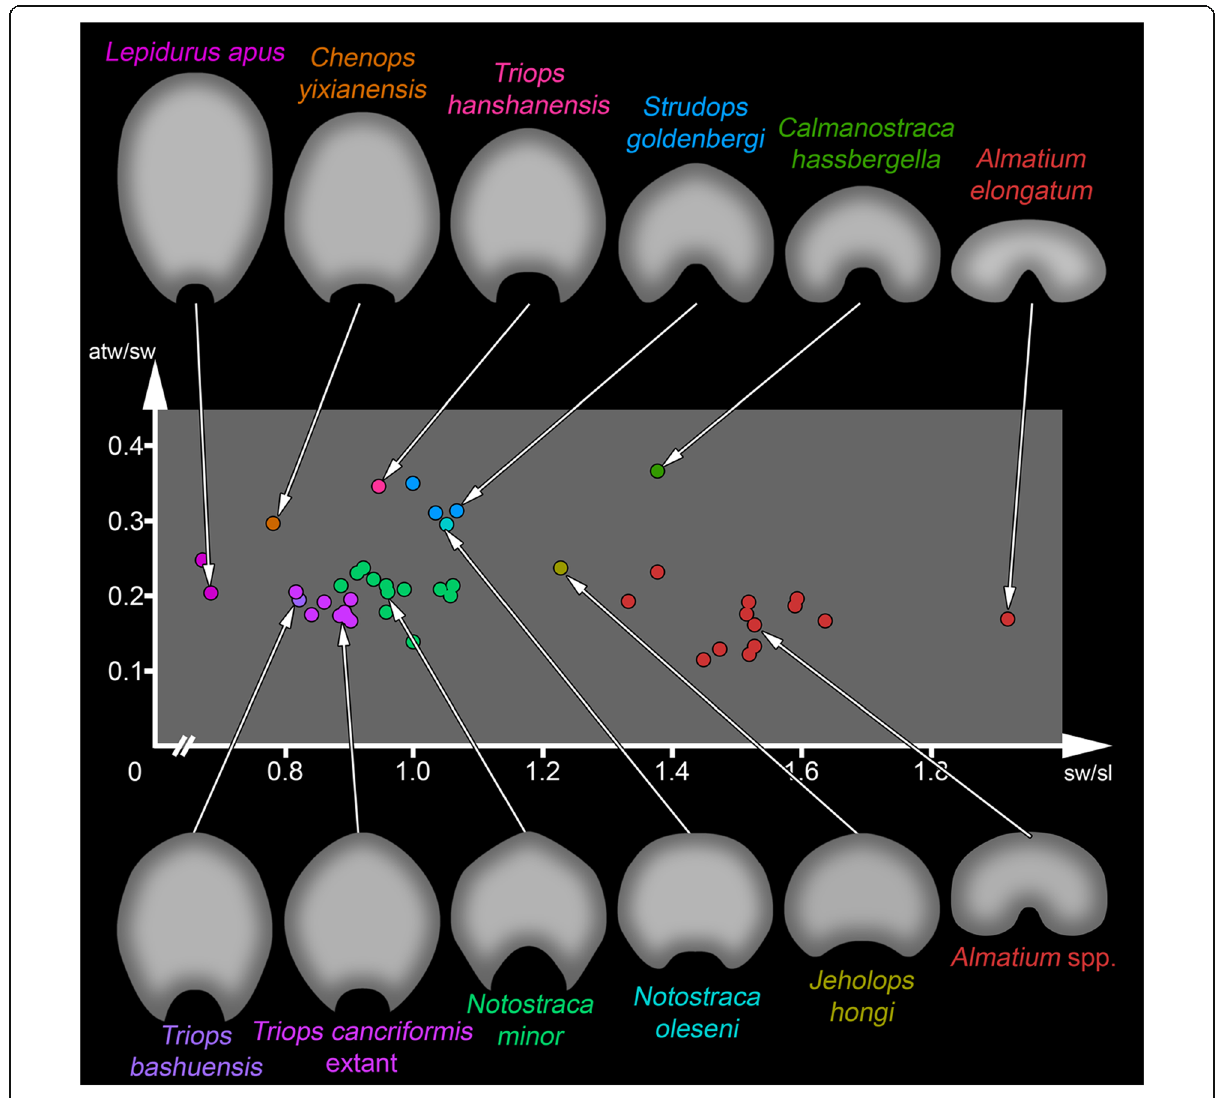
Fig. 3 Anterior trunk width/shield width vs. shield width/shield length ratios in Notostraca oleseni and other extinct and living calmanostracans: Morphospace analysis using ratios. Overview of used material is given in Table